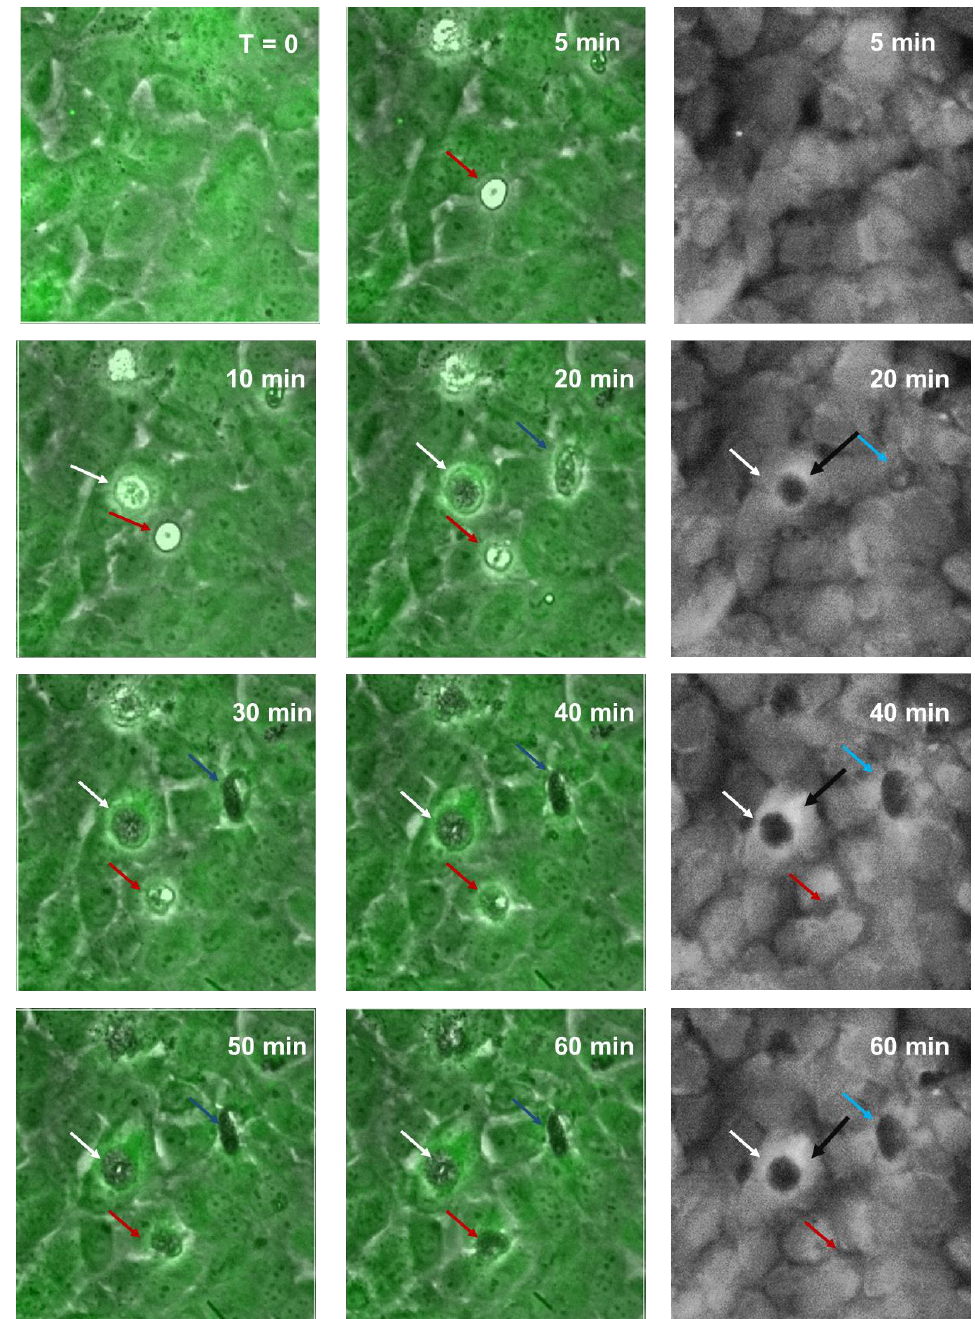
Figure 9. Time-lapse series illustrating melanoma integrating into brain endothelial layer. Images show endothelial cells stained with CMFDA-green, merged with phase only to visualise unstained spherical melanoma population (NZM7-S). Coloured arrows indicate NZM7-S that are taken up by endothelial cells. Monochrome (grey) images show green channel only to illustrate holes or pores forming within the endothelial cell body. Images shown are representative of 2 independent